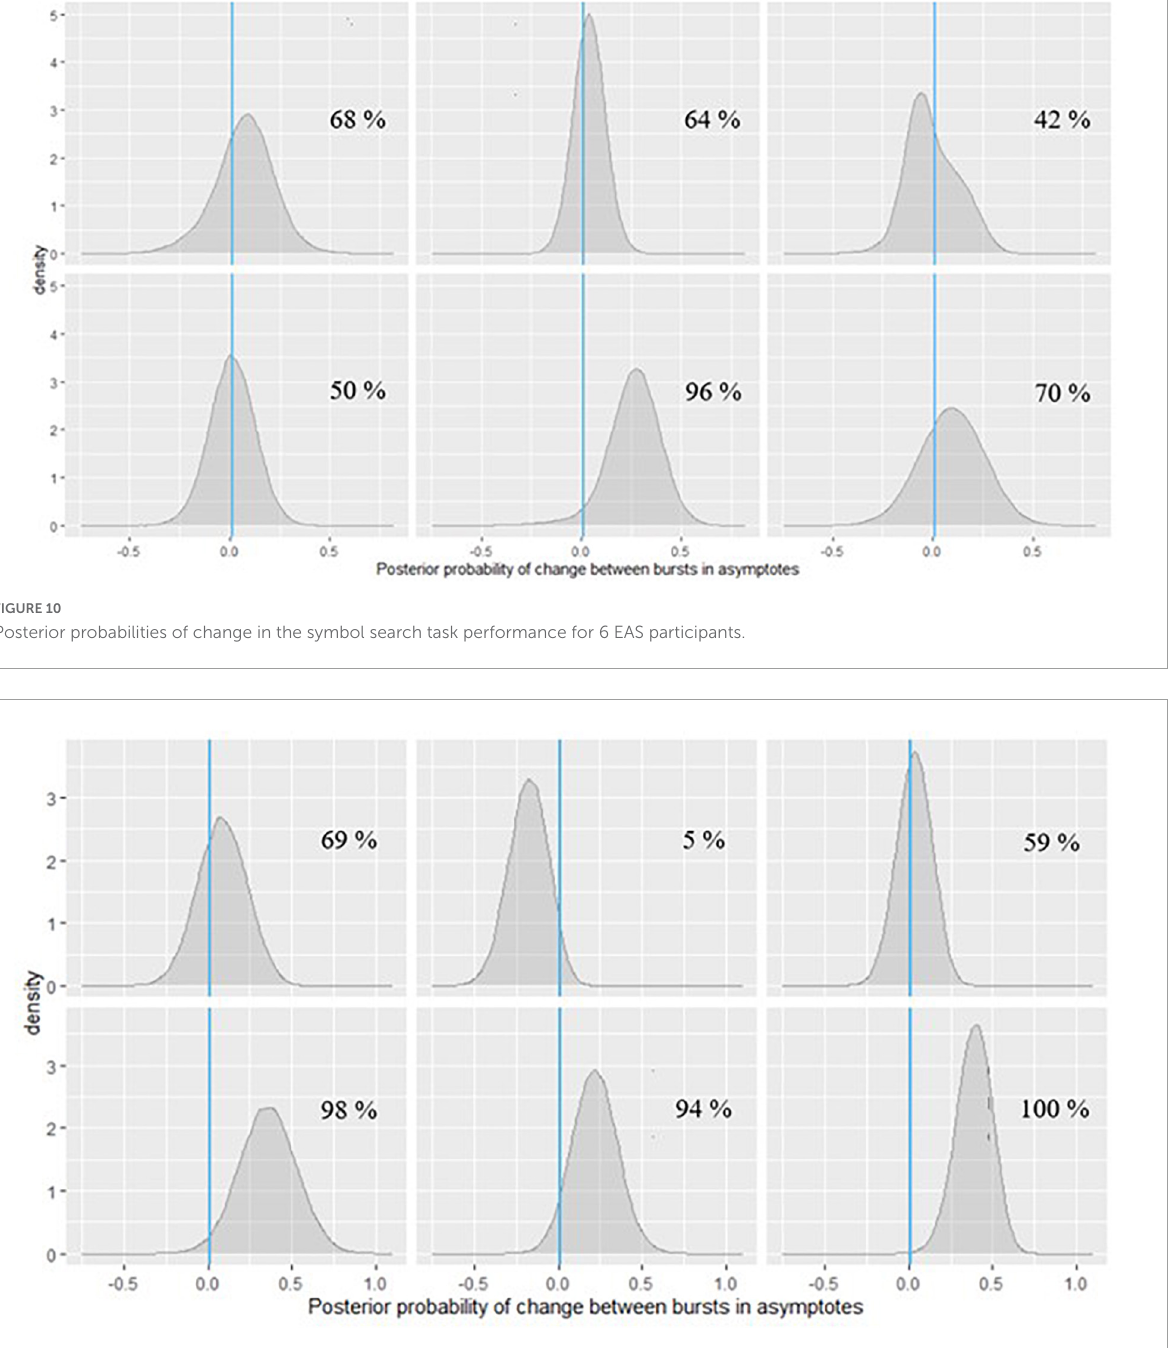
FIGURE11 Posterior probabilities of change in the grid memory task performance for 6 EAS